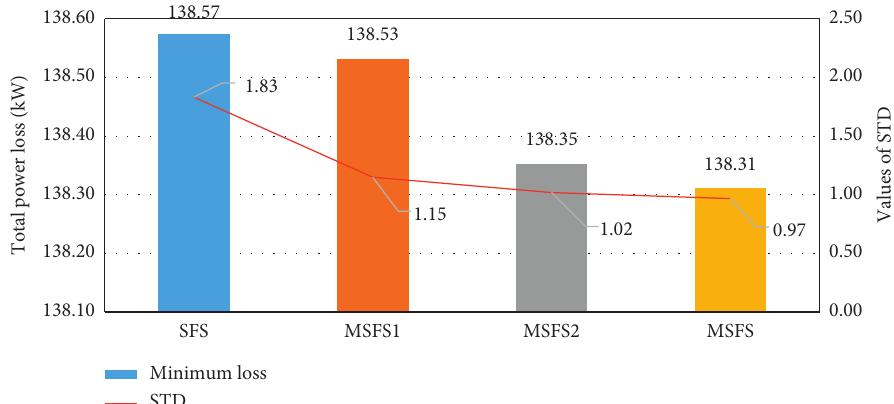
Figure 6: Minimum power loss and standard deviation of 50 trial runs obtained by SFS methods for case 2 of the 33-bus system.